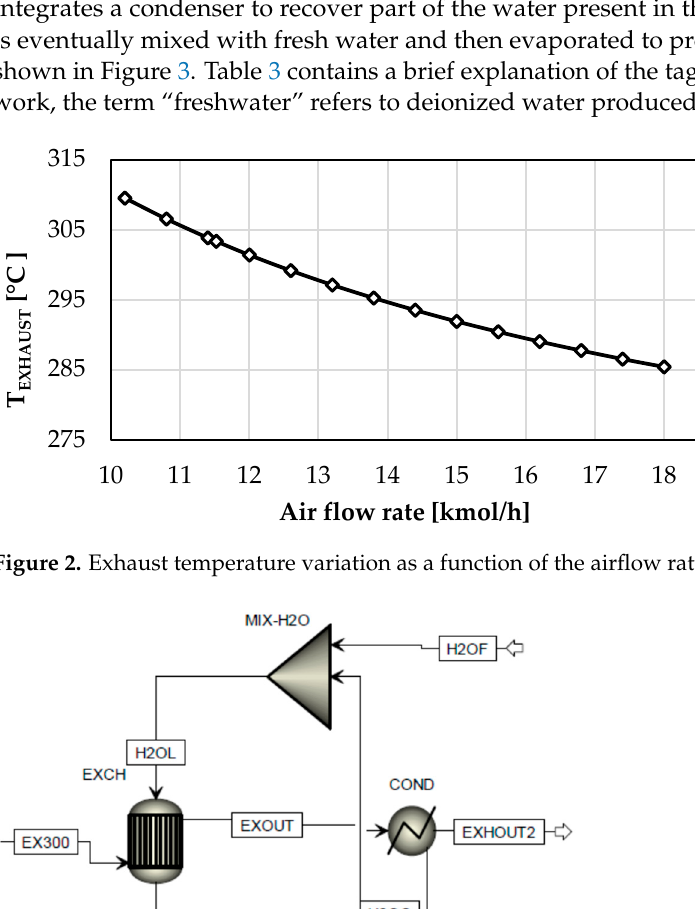
Figure 2. Exhaust temperature variation as a function of the airflow rate.